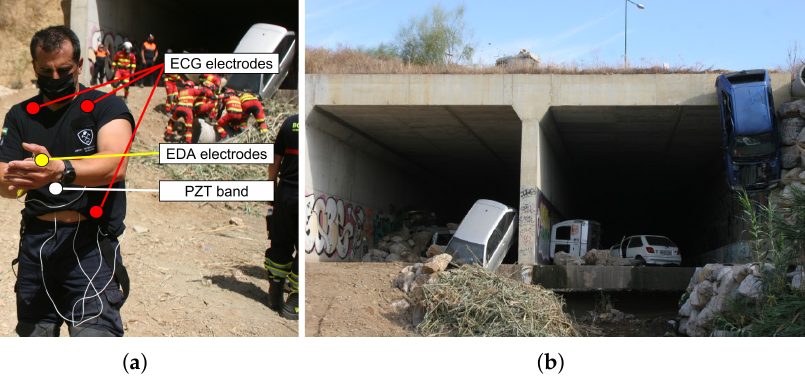
Figure 8. Real-time monitoring exercise: ( a ) deployment of bio-signal measurement devices on first responder in the initial area of operations; ( b ) tunnel entrance. Left side entrance was